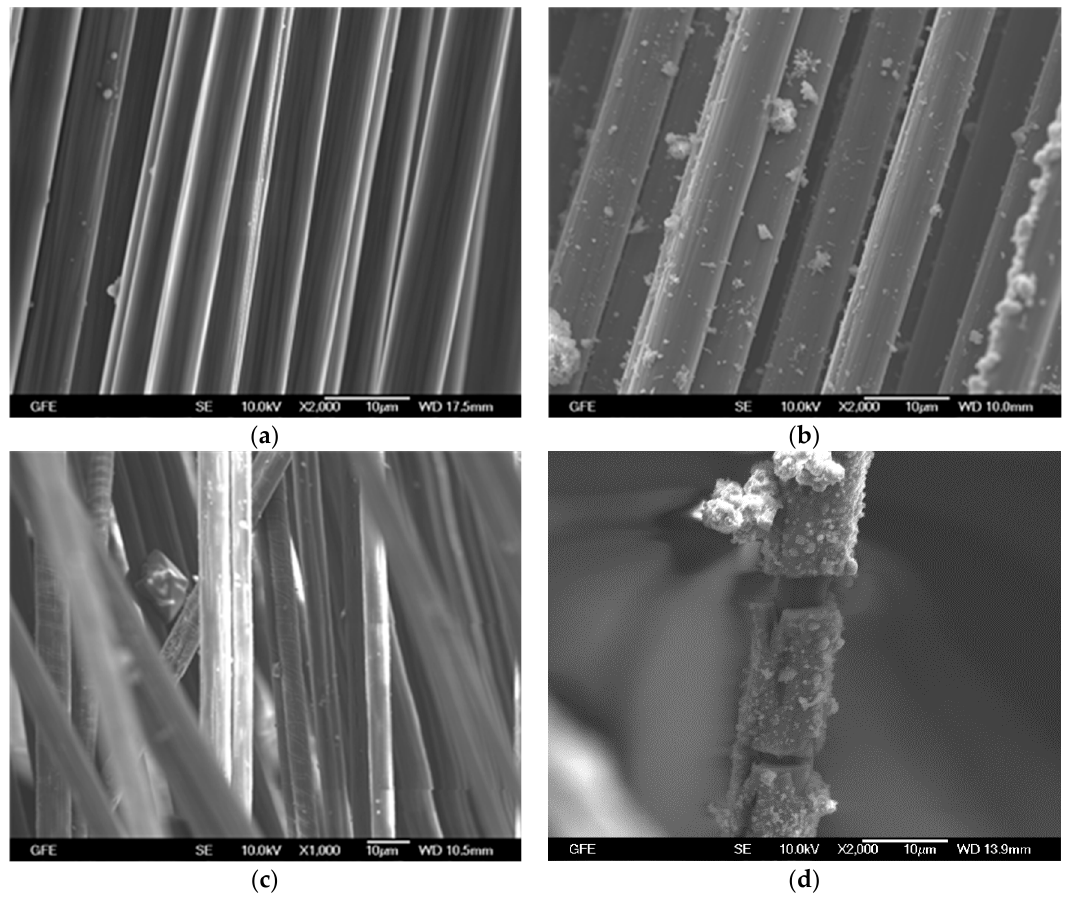
Figure 12: SEM images of UC: unpolarized reference ( a ), after polarization at level 1 ( b ), level 2 ( c ) and level 3 ( d ).